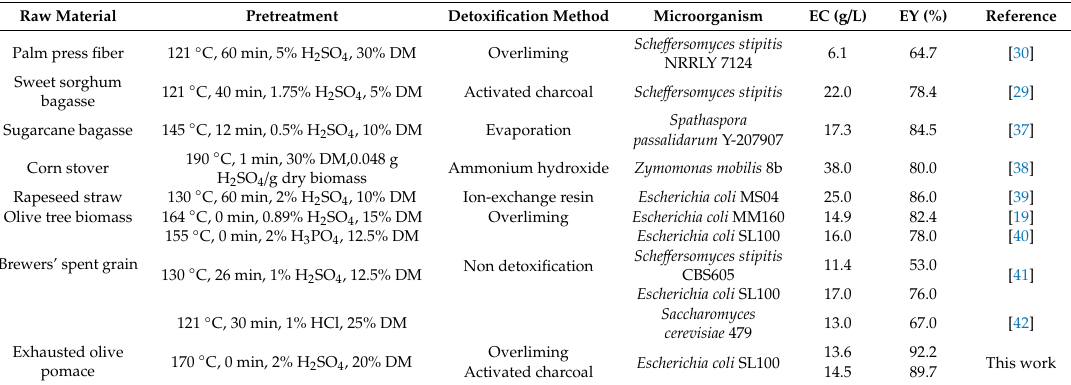
Table 3. Ethanol concentrations and yields achieved in the fermentation of hemicellulosic hydrolysates of lignocellulosic residues pretreated at di ff erent